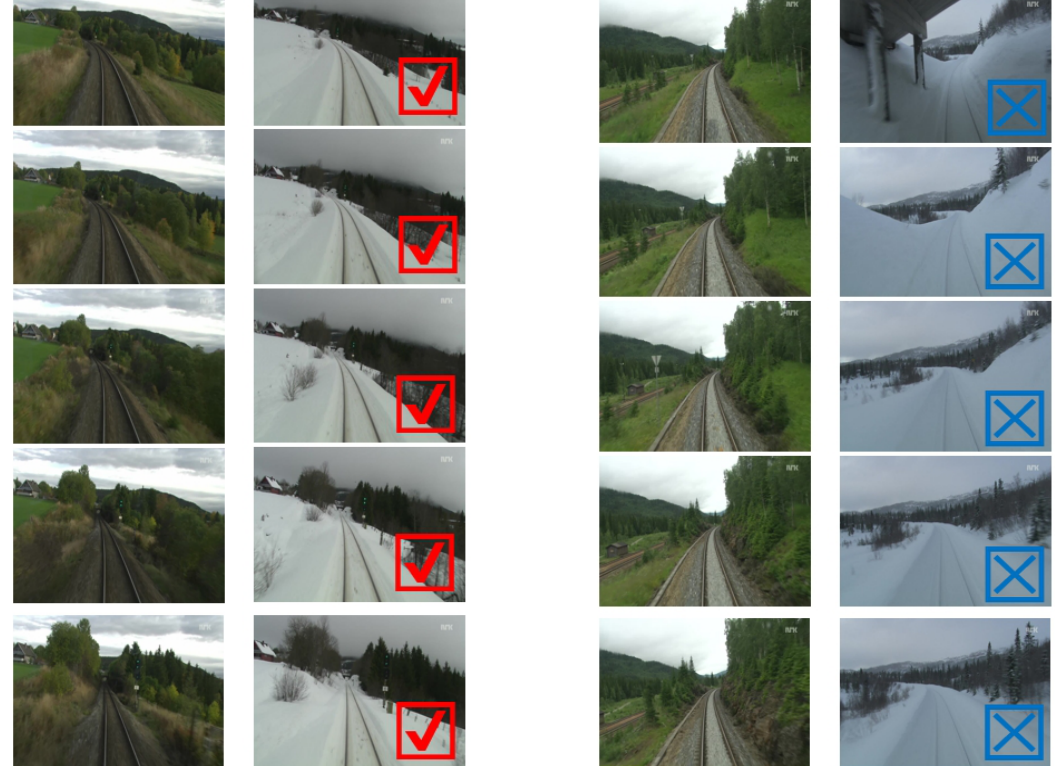
Figure 10. Corresponding frames from sequence matching in two cases (“fall vs. winter” and “summer vs. winter”). In each sub-figure, the left column shows image frames queried from one season traversal, and the right column shows the image frames recalled by our